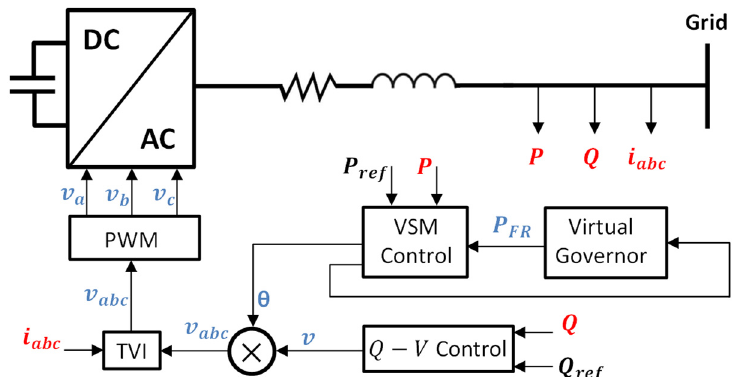
Figure 1. Schematic view of the battery energy storage system (BESS) converter control.